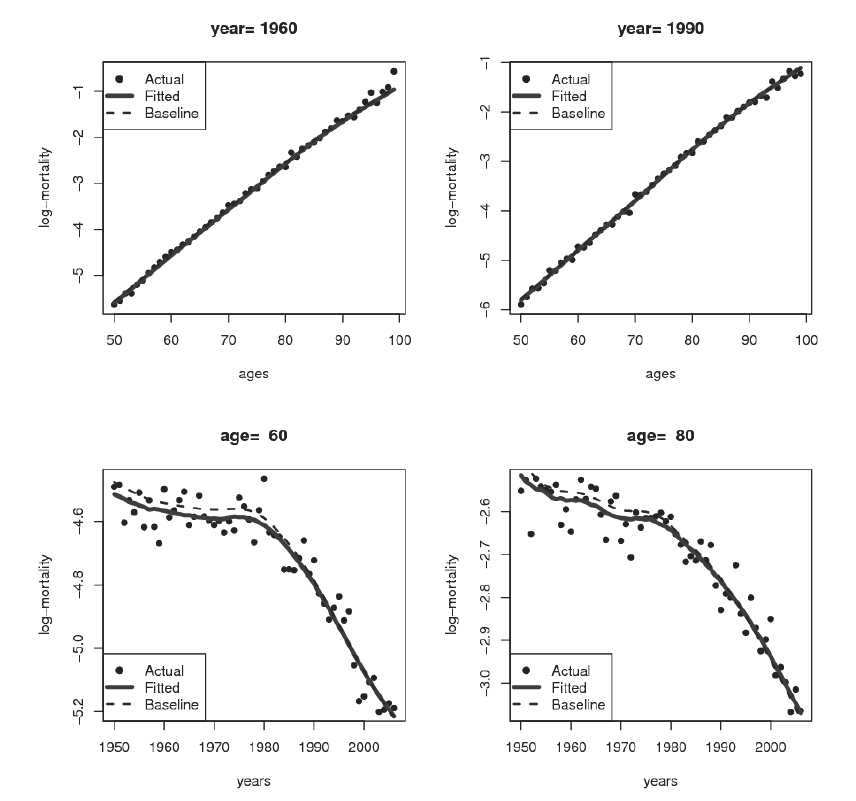
Figura 4 – Observed and fitted mortality rates for selected years and ages. Ip = H and Ic = m 0 . Swe- den,